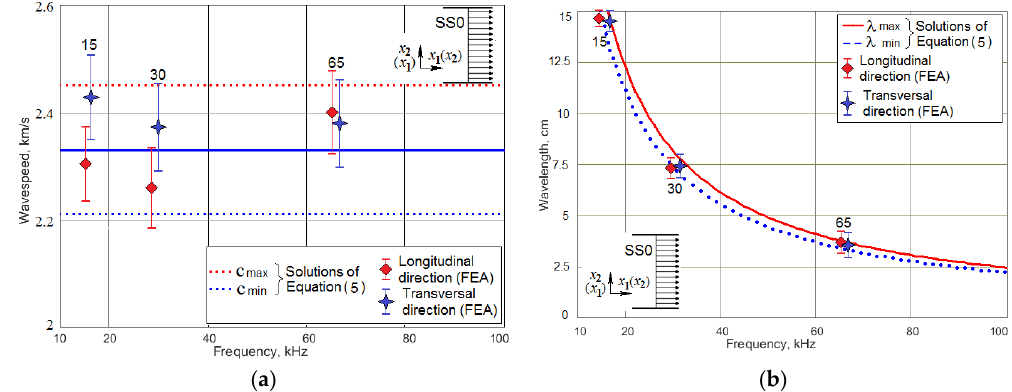
Figure 2. The dependencies of the wavespeeds ( a ) and the wavelengths ( b ) on the frequency for the symmetric horizontally polarized shear waves SS0 propagating along and across the main axis x 1 of orthotropic symmetry.